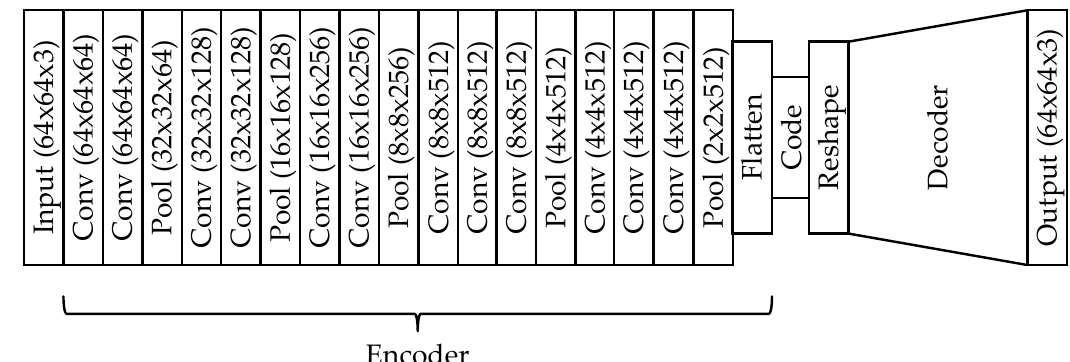
Figure 12. Architecture of the convolutional autoencoder. The VGG16 architecture was used to implement the encoder. The decoder is implemented using the inverted structure of the encoder. We optimized the number of neurons in the code using the mean squared